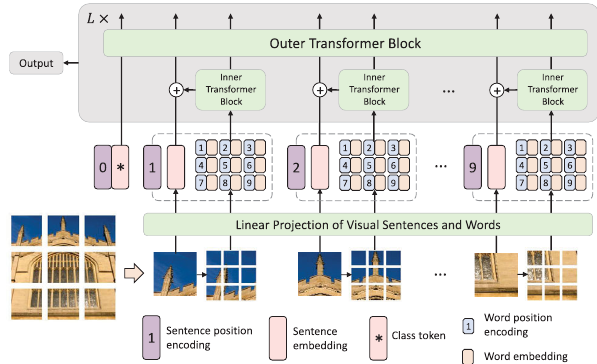
Framework of TNT. Reproduced with permission from Ref. [16], c (cid:2) The Author(s)